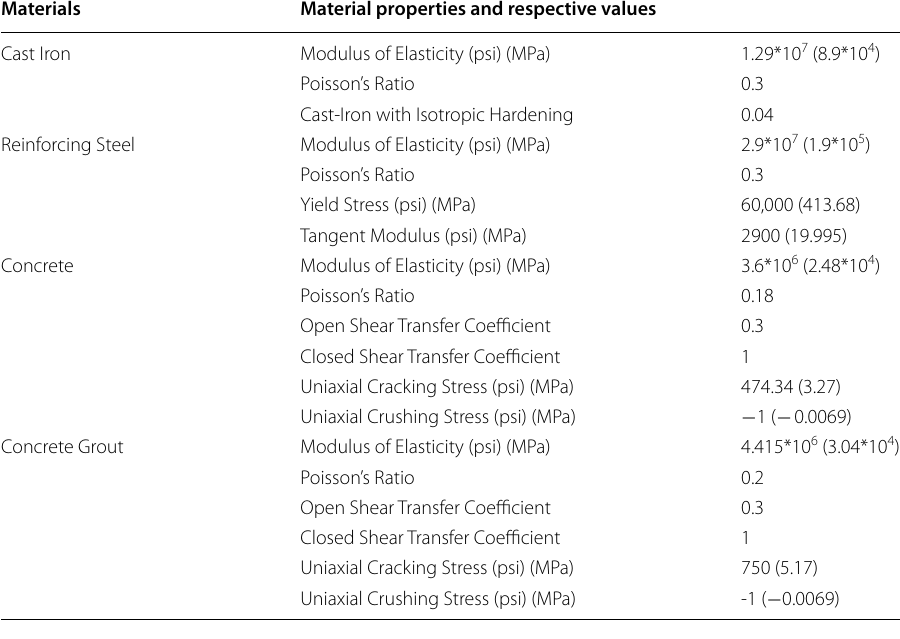
Table 5 Material Properties for Finite Element Model (FEM) Materials Material properties and respective values Cast